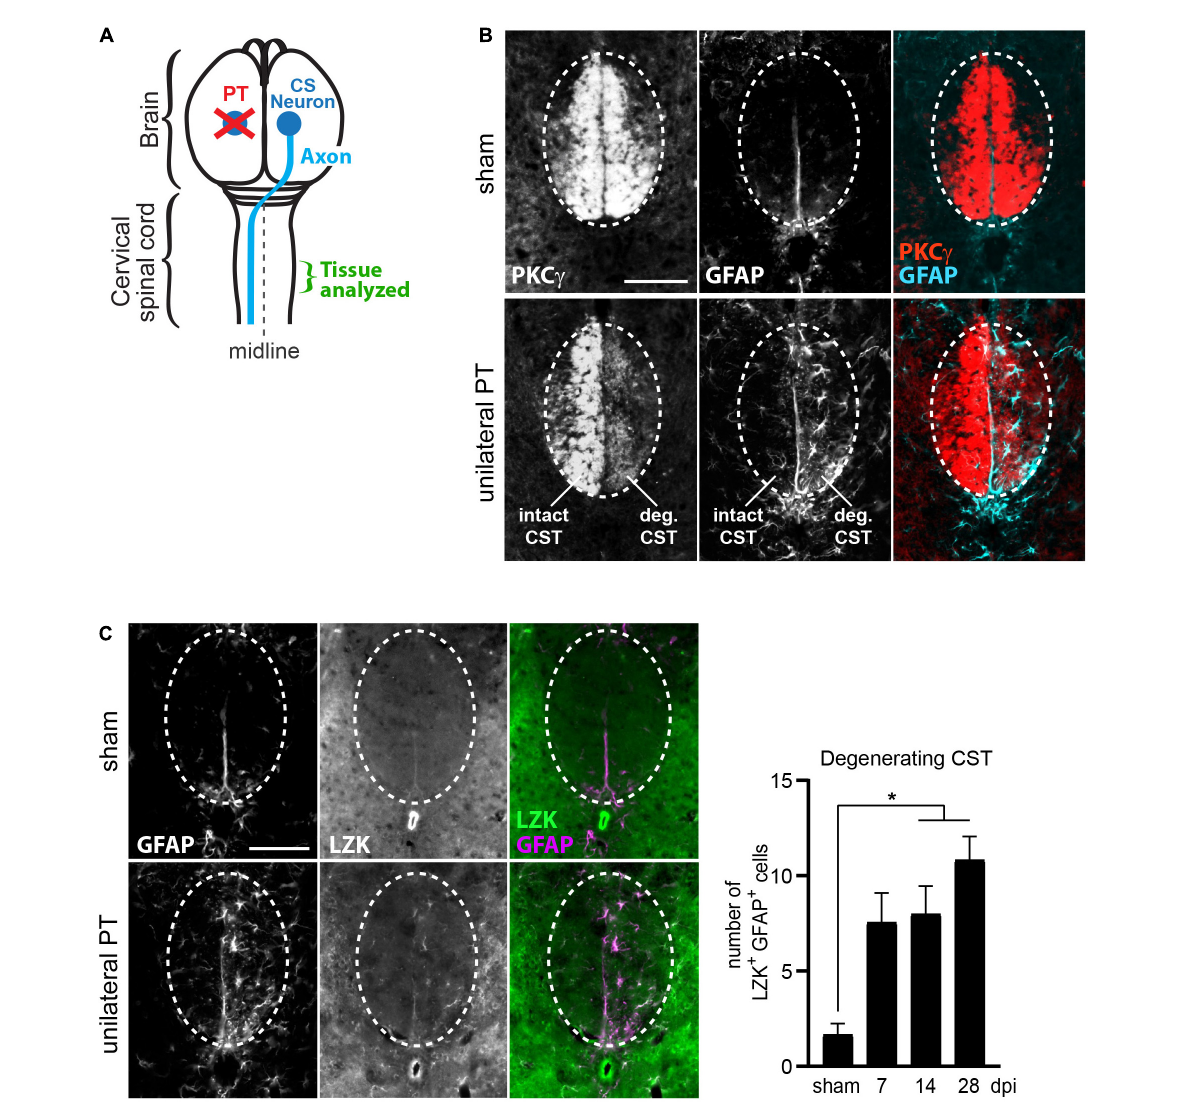
FIGURE1 Upregulation of LZK expression in reactive astrocytes localized to the degenerating CST. (A) Illustration of unilateral photothrombosis (PT, red X) targeted to the forelimb sensorimotor cortex in one hemisphere of the mouse brain. Corticospinal (CS) axons (blue line) originating from CS neurons (blue circle) in the uninjured hemisphere decussate at the medulla and extend down the spinal cord, whereas CS axons originating from neurons ablated by photothrombosis undergo degeneration. Tissues from the cervical enlargement of the spinal cord at C7 were analyzed by immunohistochemistry in this study. (B) Immunofluorescence staining of PKC γ and GFAP in the corticospinal tract (CST) at the cervical spinal cords in wildtype mice without injury or 14 days post injury (dpi, unilateral PT). Dotted ovals outline the CST; intact and degenerating (deg) hemi-CSTs are indicated; scale bar represents 100 µ m. (C) Left , immunofluorescence staining of endogenous LZK and GFAP in the CST at the cervical spinal cords of wildtype mice without injury or on 14 dpi. Dotted ovals outline the CST; scale bar represents 100 µ m. Right, quantification of the number of LZK + GFAP + cells localized to the degenerating CST in the cervical spinal cord on 7, 14, and 28 days after unilateral PT. n = 3 per timepoint; graphing mean with SEM. By one-way ANOVA, p < 0.05 for main injury effect. Asterisk (*) on graph indicates p < 0.05 for post-hoc comparison between sham and the post-injury timepoints of 14 dpi or 28 dpi with Bonferroni